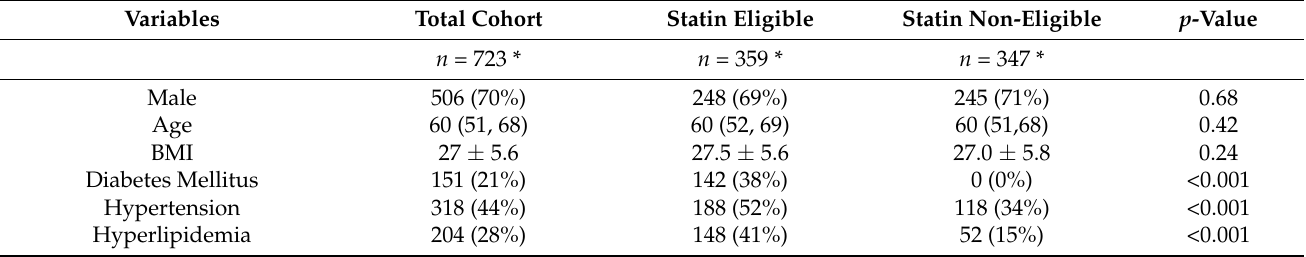
Table 1. Demographics—Comparison of statin eligible vs. statin non-eligible groups based on PCE